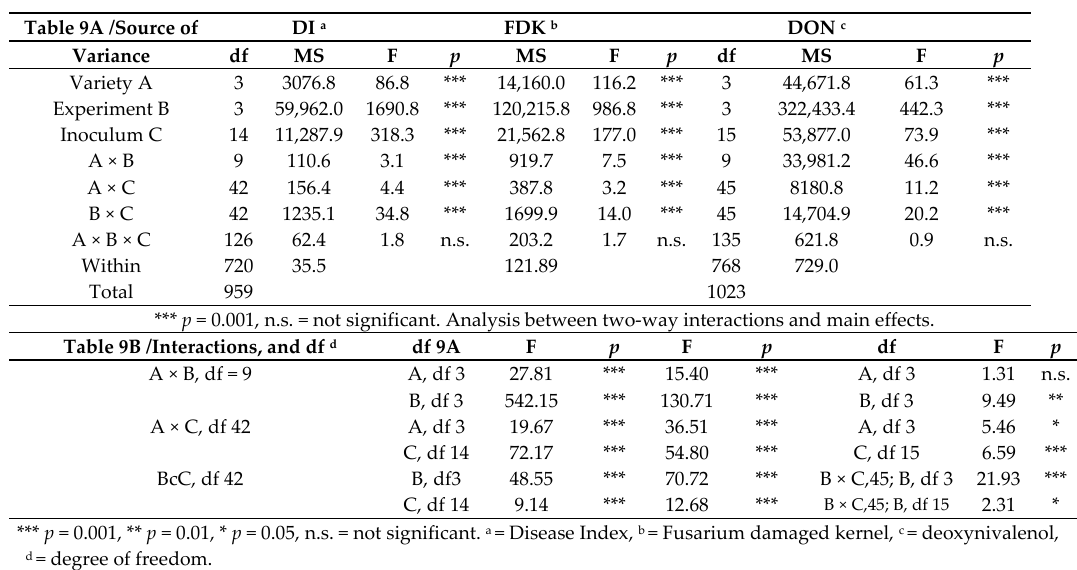
Table 9. Response of wheat to the different isolates and their mixtures. ANOVAs for the three traits, FHB, FDK and DON, Szeged, 2013–2015. Table 9A /Source of DI a FDK b DON c Variance df MS F p